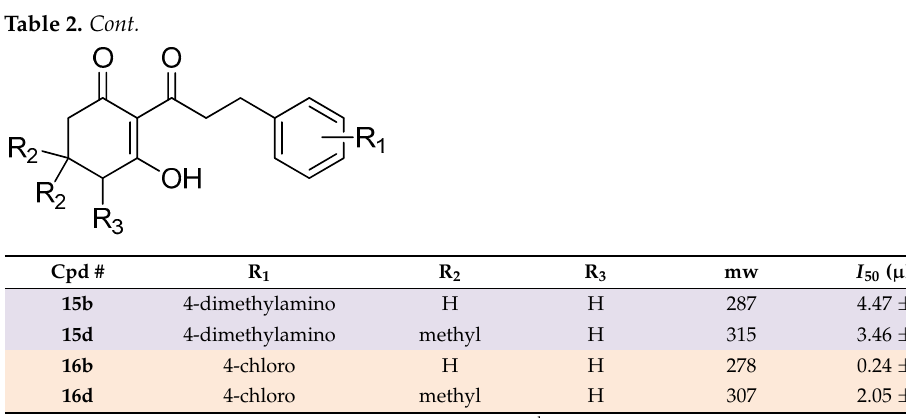
Table 2. Structures and activities of 17 cyclohexane-1,3-diones with phenyl side chains tested in this study. Table 2. Cont.